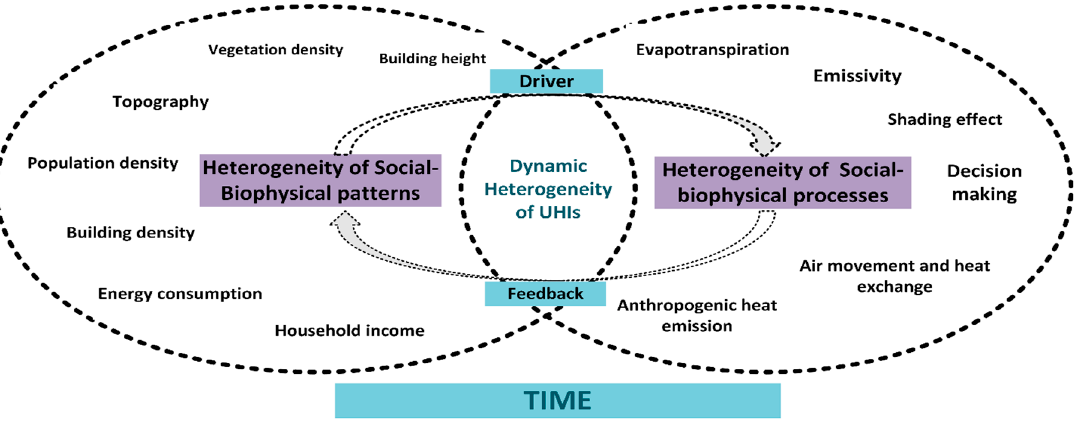
Figure 3. Dynamic heterogeneity approach in UHI: The interactions between four biotic–physical– social–built heterogeneous layers (variables in the left oval) make a heterogeneous pattern. The right oval shows different kinds of energy and material, biotic differentiation, and human action processes that interact reciprocally.